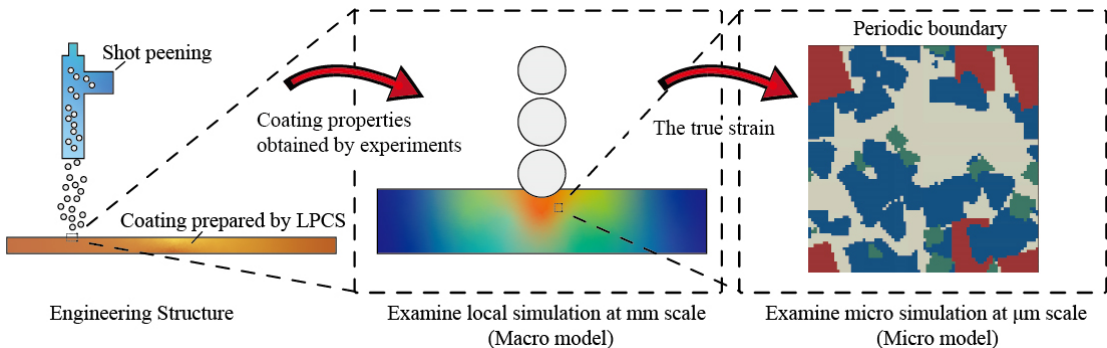
Figure 3. The research framework for multiscale simulation of SP-LPCS.